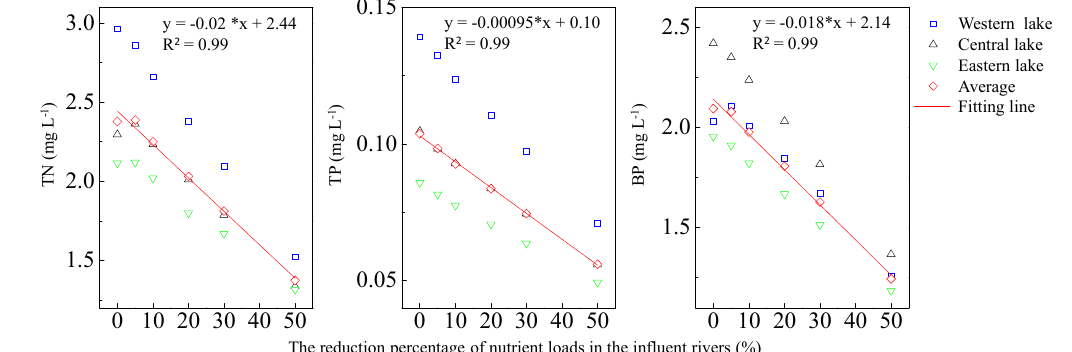
Figure 8. Load-responses curve for TN, TP, and BP.